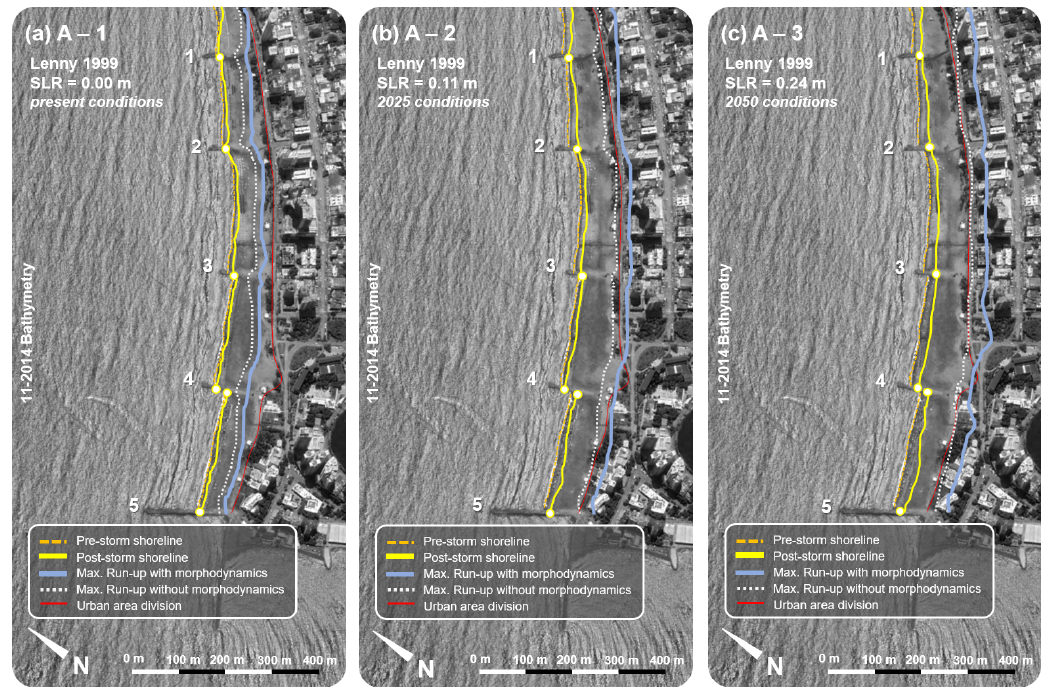
Figure 3. Maximum flood range (with and without morphodynamics) and post-storm shorelines simulated by XBeach for a storm similar to Lenny 1999 with different SLR conditions. Map base images retrieved from © Google Earth and modified by the authors.